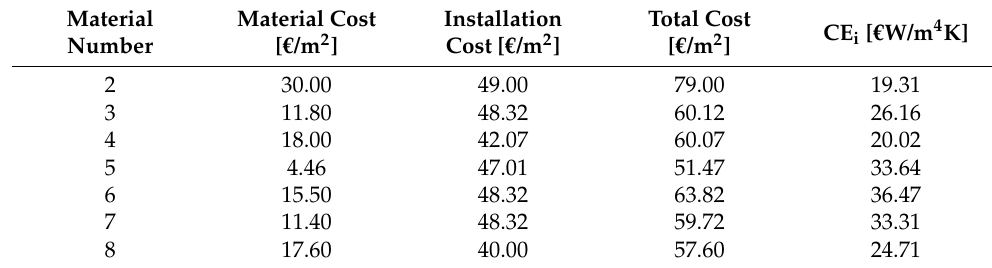
Table 7. Material, installation, and total cost, with the cost-effectiveness index for the heat-reflective